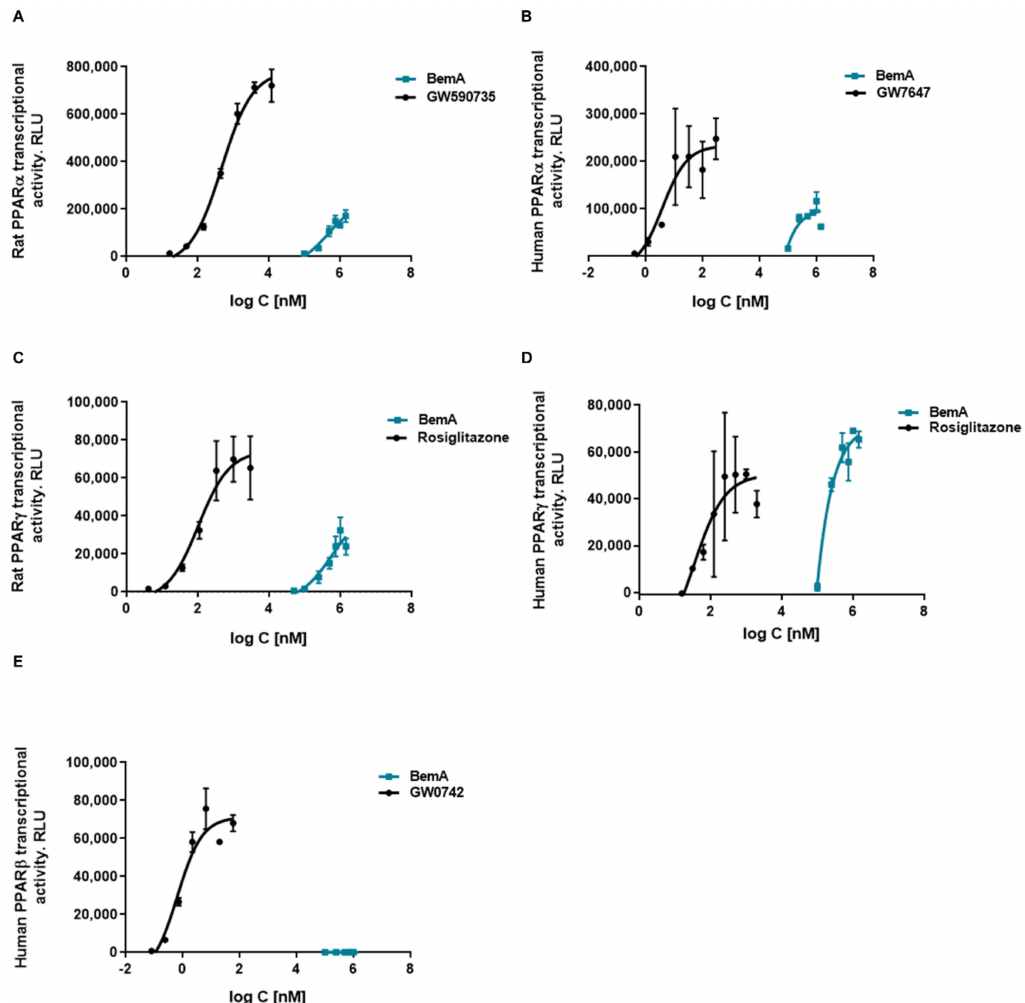
Figure 8. Concentration response curves of bempedoic acid in a cell-based reporter gene assay. Effects of bempedoic acid (BemA) on rat PPAR α ( A ), human PPAR α ( B ), rat PPAR γ ( C ), human PPAR γ , ( D ) and human PPAR β ( E ) luciferase reporter gene expression. GW590735, GW7647, rosiglitazone, and GW0742 were used as positive controls, respectively. RLU = relative light units. The average of 2–3 measurements and standard deviations are shown. Table 2. EC50 and Emax values for bempedoic acid and standard PPAR agonists.